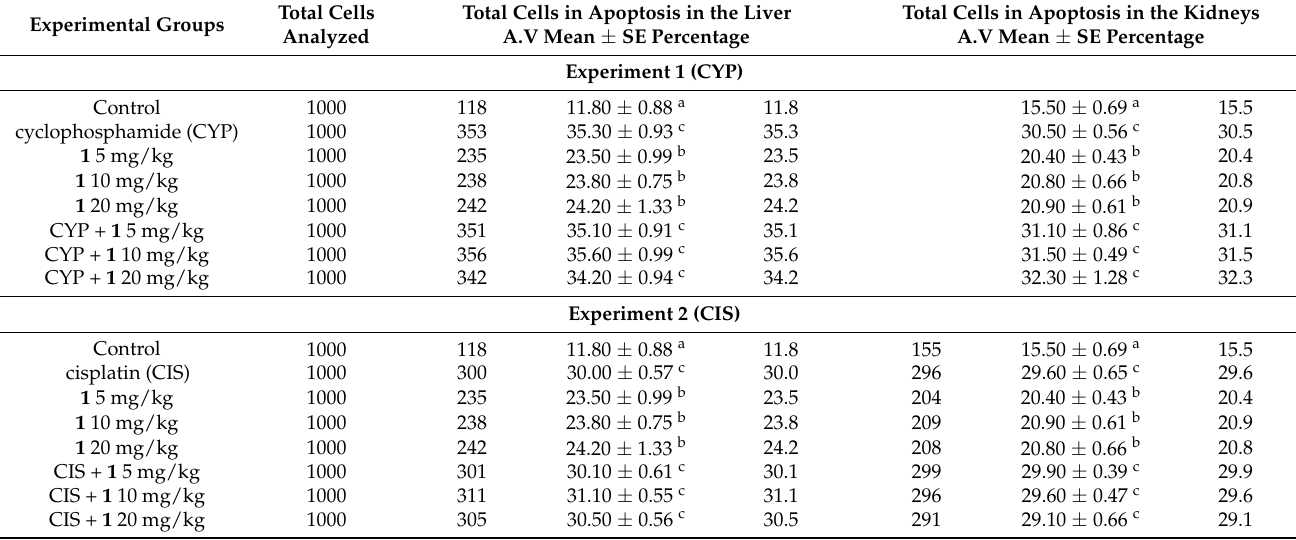
Table 5. Absolute value, mean ± Standard error of liver and kidney cells in apoptosis, Swiss mice (males), treated with different doses of 1 , associated with cyclophosphamide and